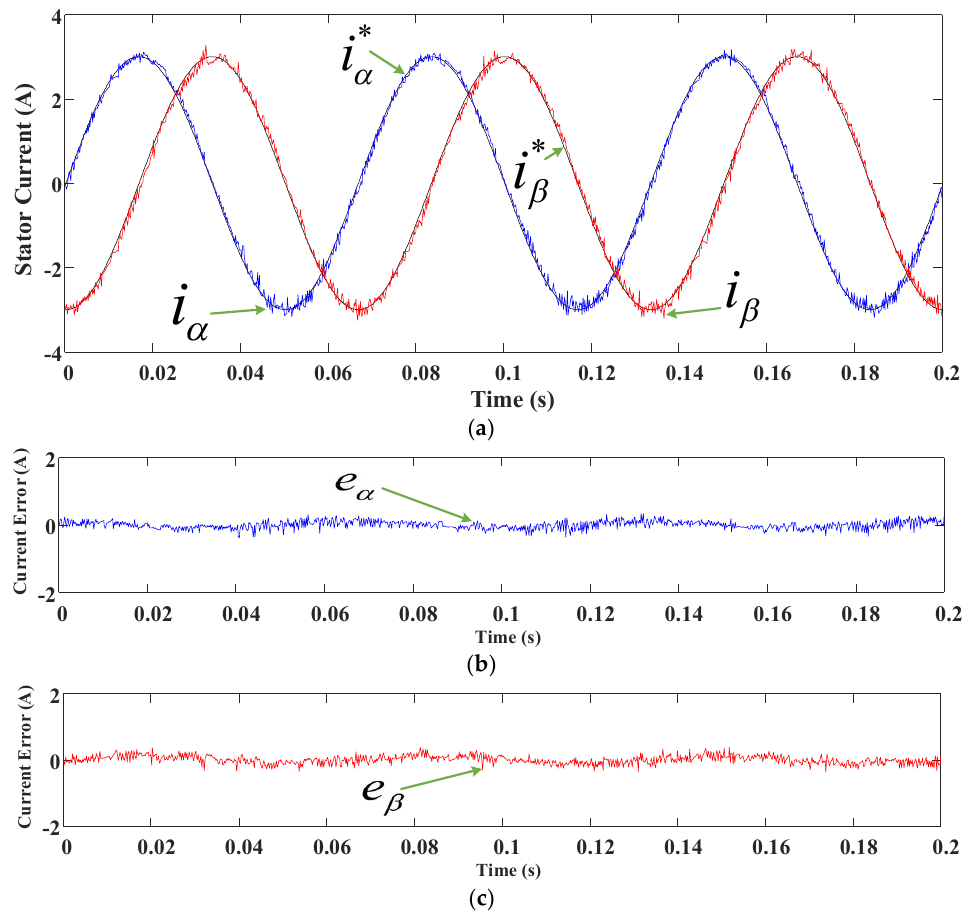
Figure 15. Experimental results of DVV-MFPCC following a sinusoidal current command with amplitude 3 A and frequency 30 Hz (case 2): ( a ) current responses; ( b ) α -axis current error; ( c ) β -axis current error.